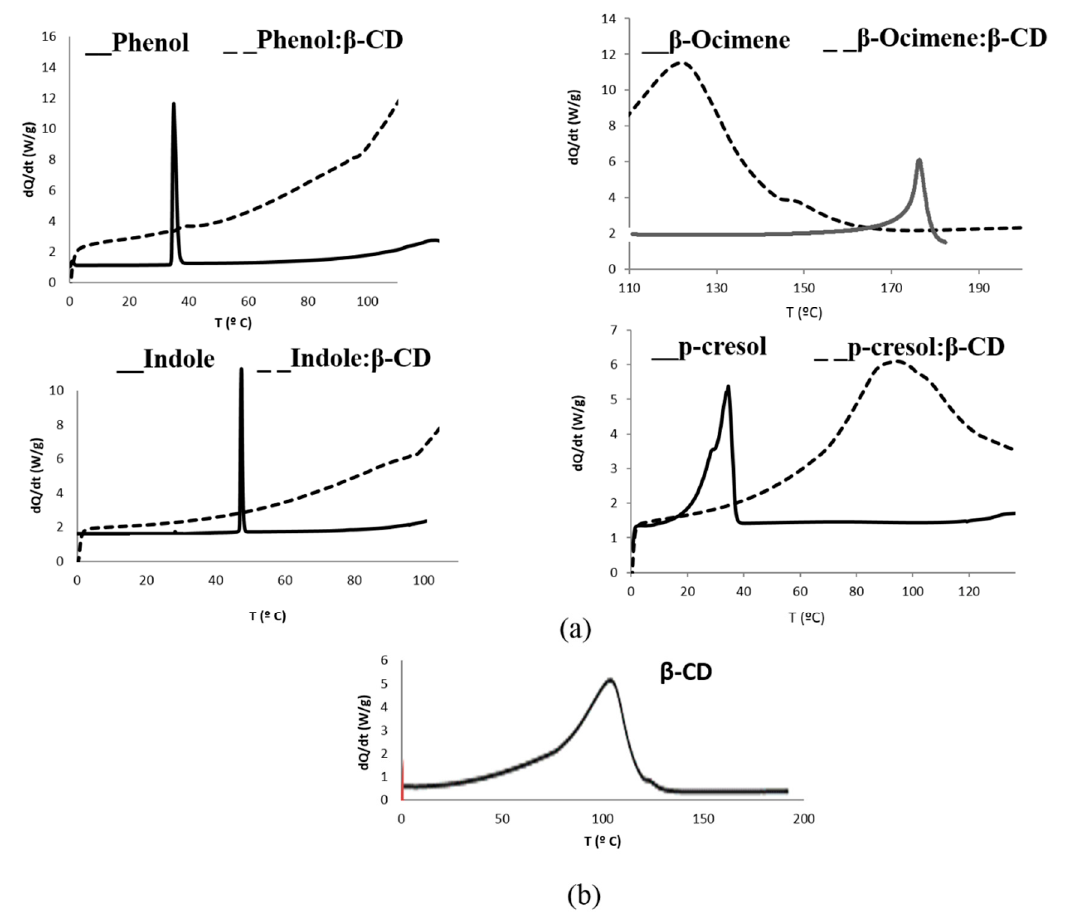
Figure 2. ( a ) Thermograms obtained for free (__) and microencapsulated biottractans (- - -) and ( b ) β -CD.